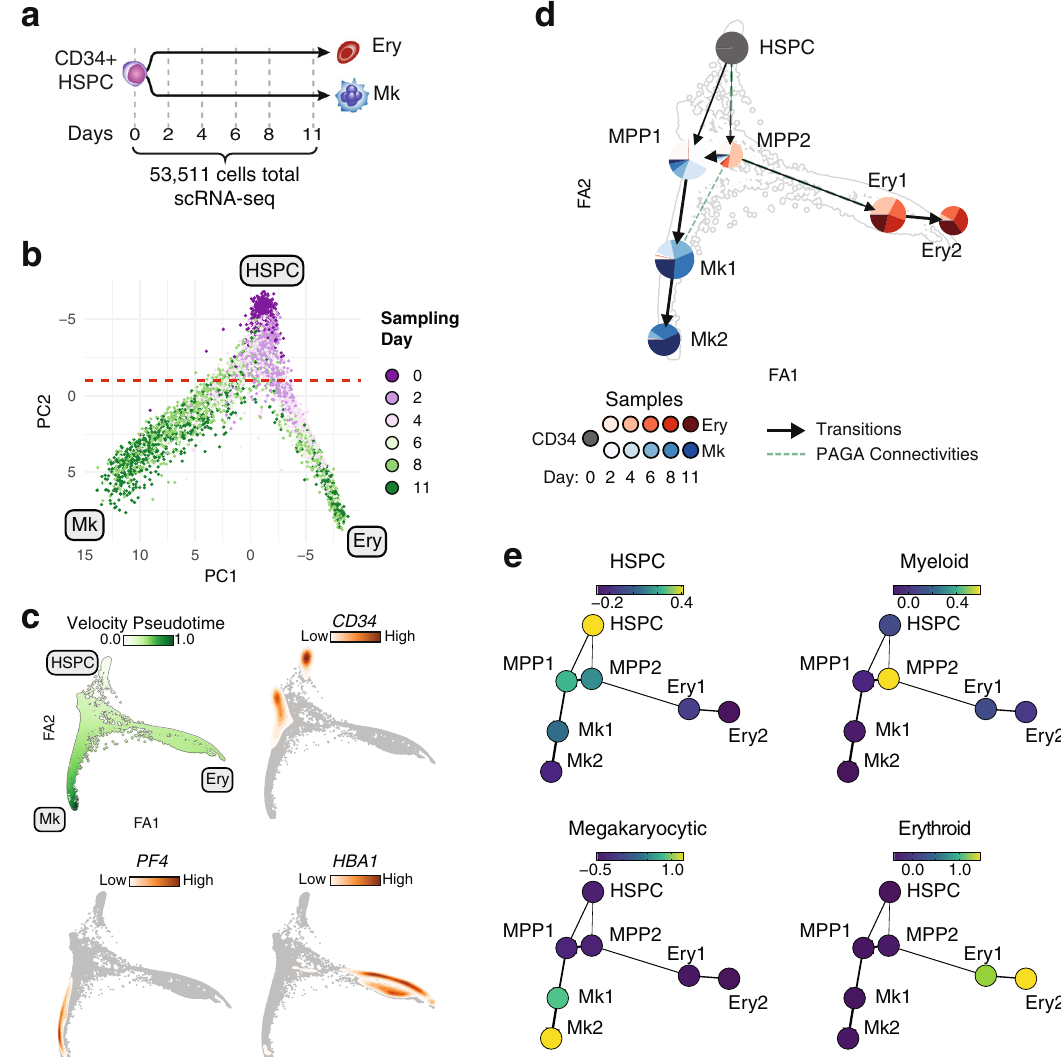
Fig. 6 Single-cell gene expression dynamics demonstrate distinct cell states during erythroid and megakaryocytic differentiation. a Schematic diagram of the single-cell gene expression timecourse experiment along ex vivo erythropoiesis and megakaryopoiesis. b PCA using the top 2000 variable genes. Cells are colored by sampling day. Terminal erythroid (Ery) and megakaryocytic (Mk) states, as well as initial HSPC state are annotated. Red line denotes where 90% of the cells sampled prior to day 4 are located (above line). c RNA velocity-based pseudotime or gene expression density on Force-Atlas graph of all cells based on RNA velocity estimates of top 2000 variable genes. d Cell populations from collapsed Leiden clusters on FA graph. Sample composition of each population is represented as a pie chart. Arrows denote RNA velocity derived transitions between populations. Dashed lines represent PAGA connectivities. e Average expression intensity of gene sets representative of HSPC, Myeloid, Erythroid, and Megakaryocytic states on identi fi ed cell